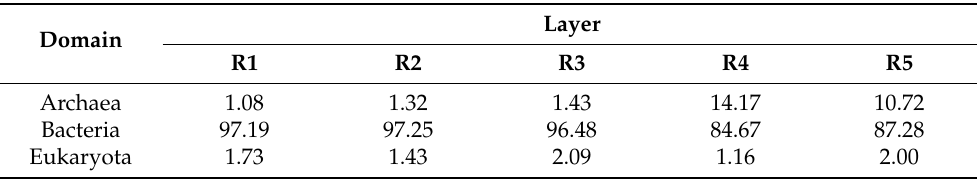
Table 1. Proportions (relative abundance, %) of archaea, bacteria, and eukaryotes in the microbial communities of the studied samples.